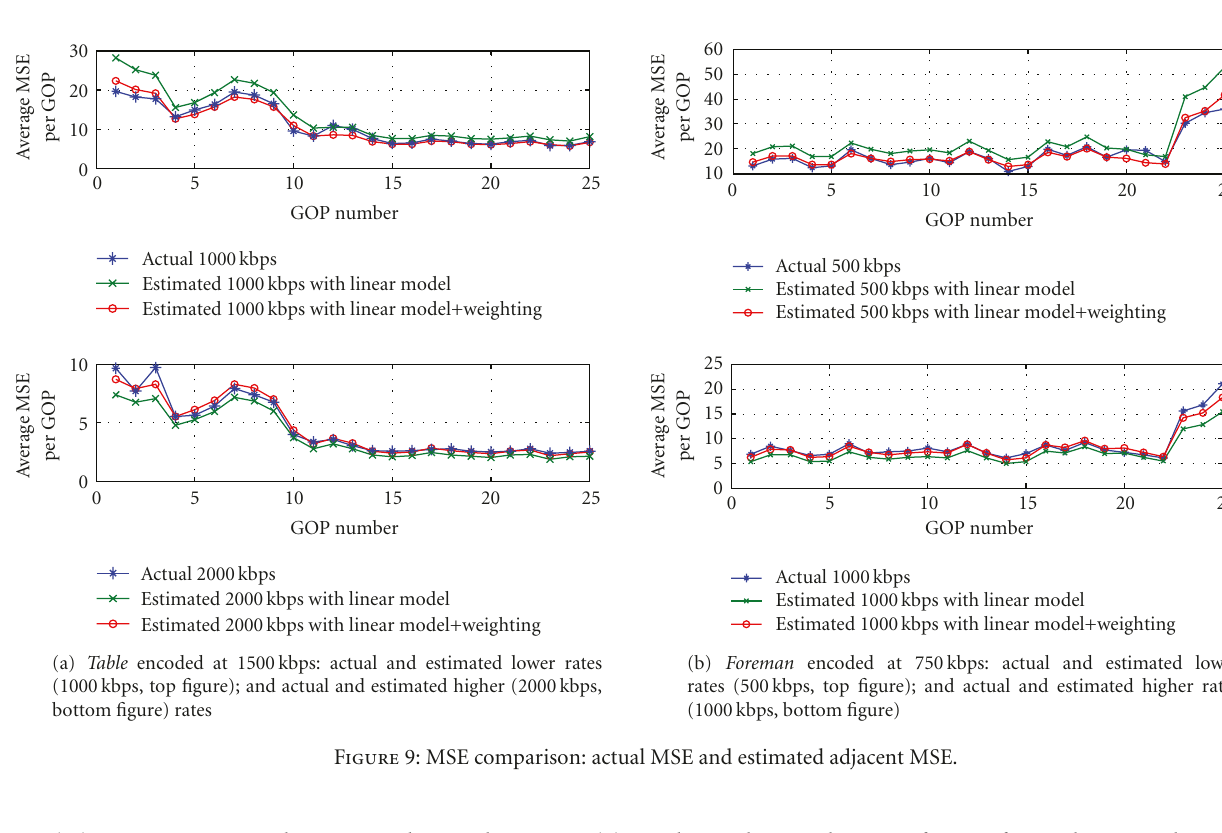
Figure 8: Model for the estimation of adjacent encoding points.